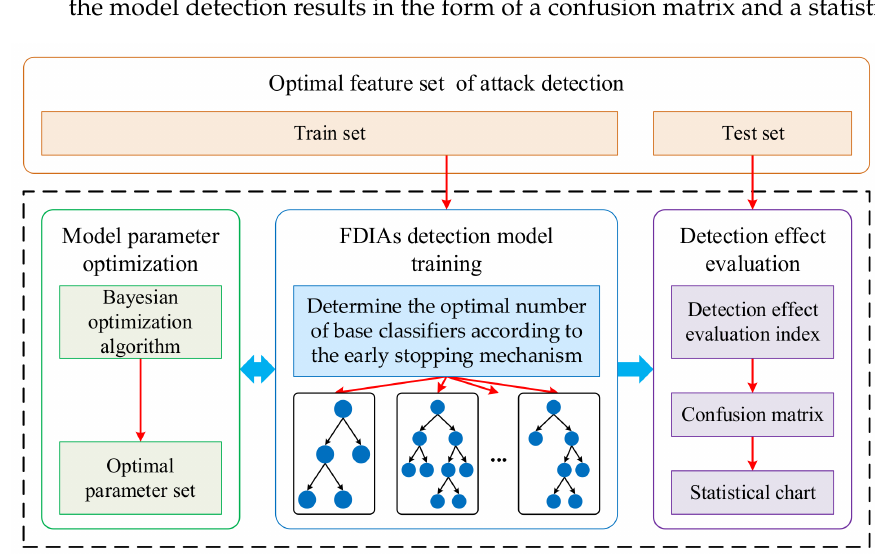
Figure 5. FDIA detection process.